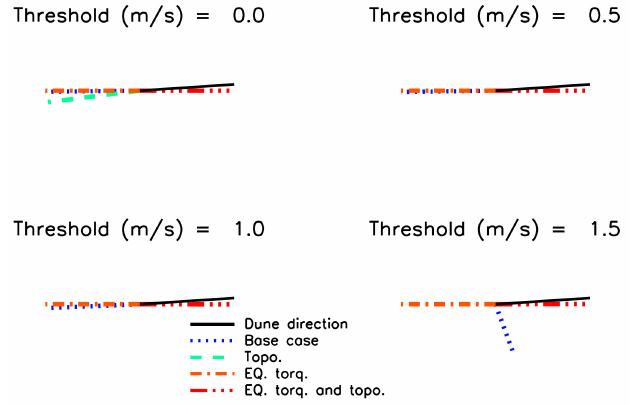
Figure 8. Direction of mean sand transport at grid cells with dunes present for four di ff erent threshold wind speeds. The north–south and east–west transport vectors are averaged for each grid cell with dunes present. This indicates the mean direction of sediment transport. Considering that most dune orientations indicate a westerly resultant drift direction (RDD), this indicates how well our average equatorial wind regime at dune locations matches the dune orientations and how that changes as a function of saltation threshold.